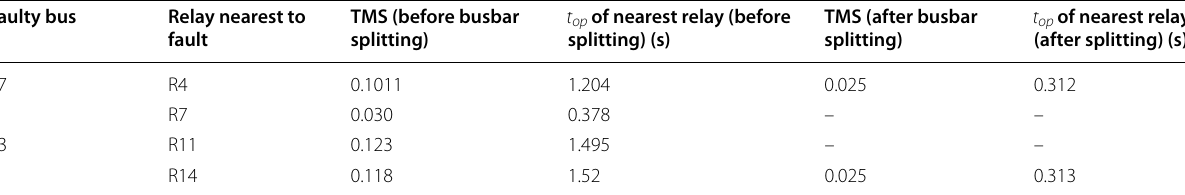
Table 8 TMS and t op of relays nearest to fault location (before and after splitting) considering multiple faults in the IEEE 30-bus system Faulty bus